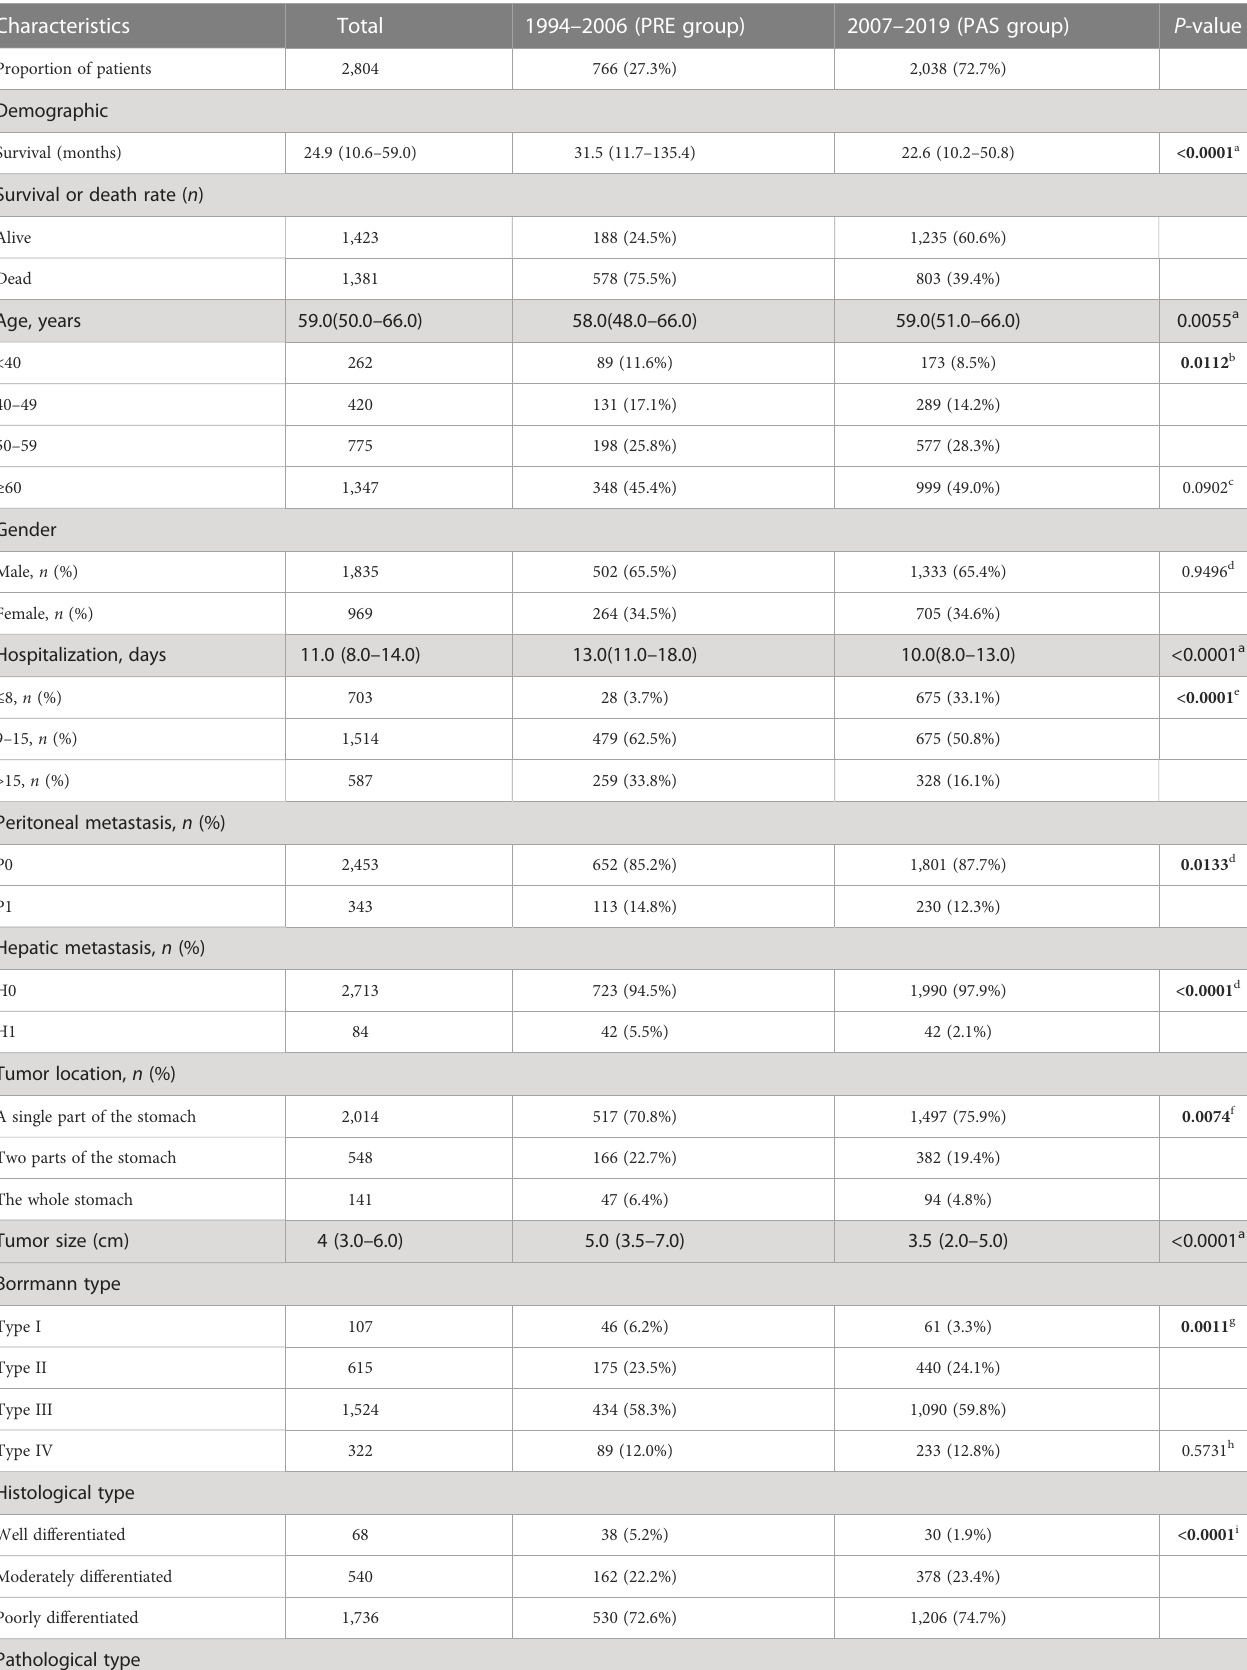
TABLE 1 Demographics and characteristics of the gastric cancer patients in the PRE group and the PAS group.